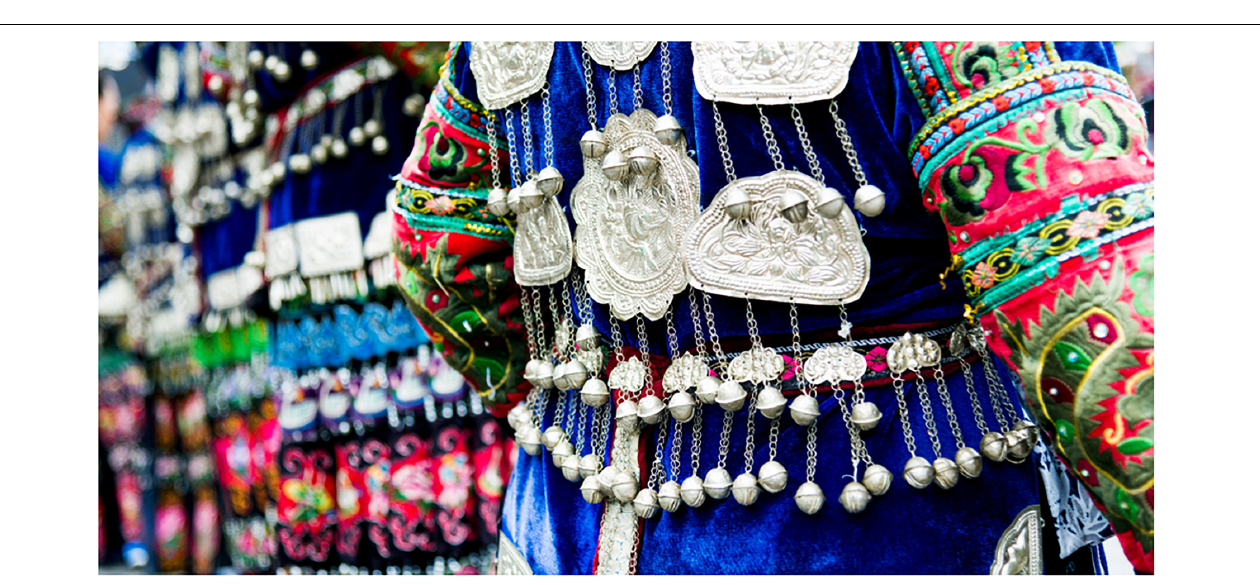
FIGURE 2 | Teaching of Miao costume making. Royalty free images reproduced with permission from Shutterstock.